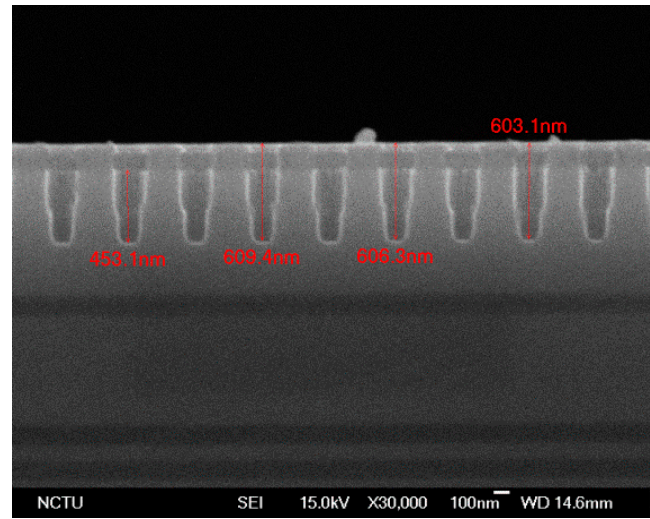
Figure 2. Cross-sectional scanning electron microscope (SEM) image of a QD PCSEL with bottom DBR.